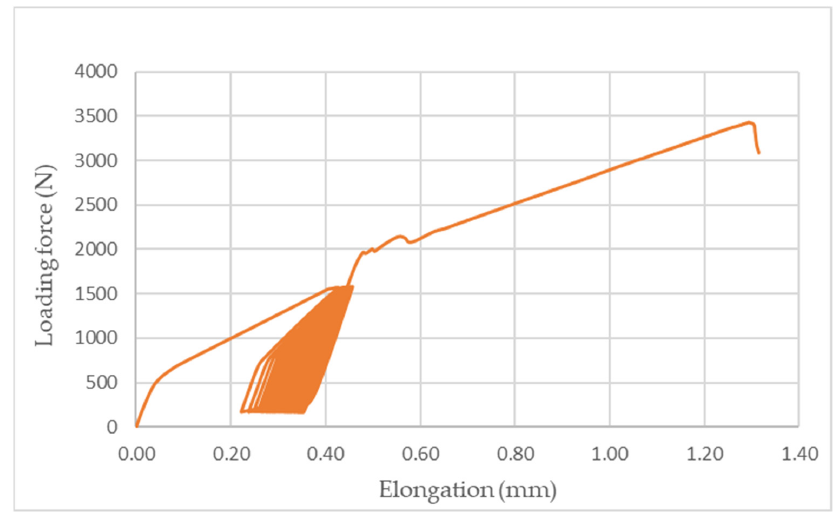
Figure 9. Quasi-static curve of AB20 adhesive bond at cyclic loading intensity 5–50%.